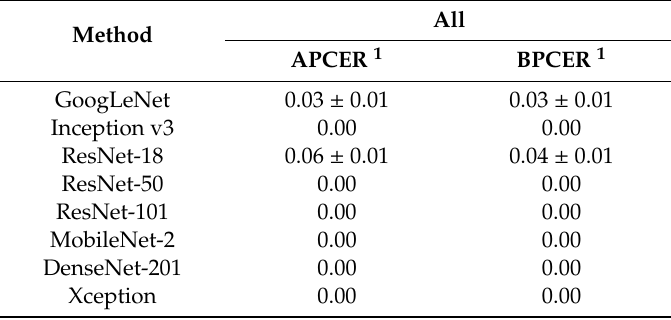
Table 7. Results of 10-fold